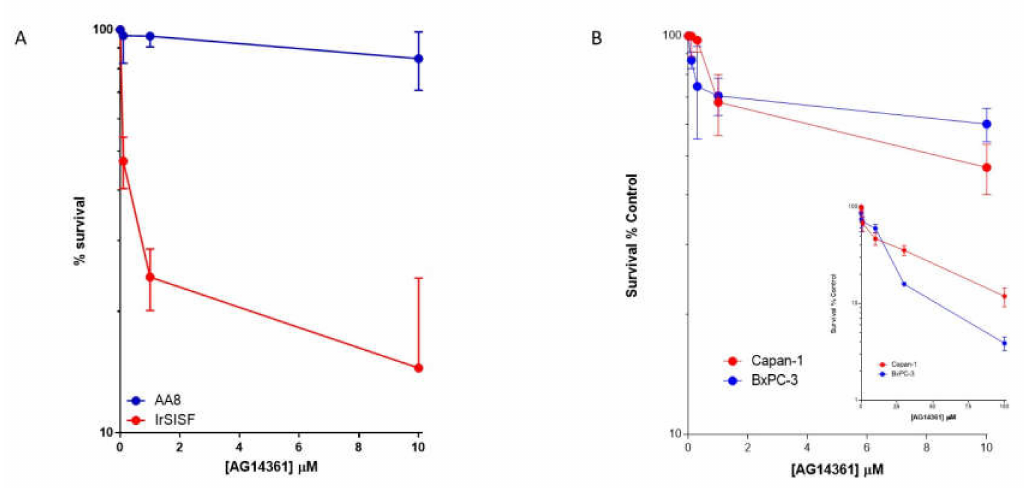
Figure 3. AG14361 is more cytotoxic in XRCC3 mutant irs1SF cells compared to wild-type AA8 Chinese hamster ovary cells ( A ) but BRCA2 mutant Capan-1 cells are not more sensitive than BRCA wild-type BxPC-3 pancreatic cancer cells ( B ). Cells were exposed to increasing concentrations of AG14361 for 24 h prior to seeding for colony formation in fresh medium. The insert shows an extended concentration range for pancreatic cell lines. Previously unpublished data pooled from three independent